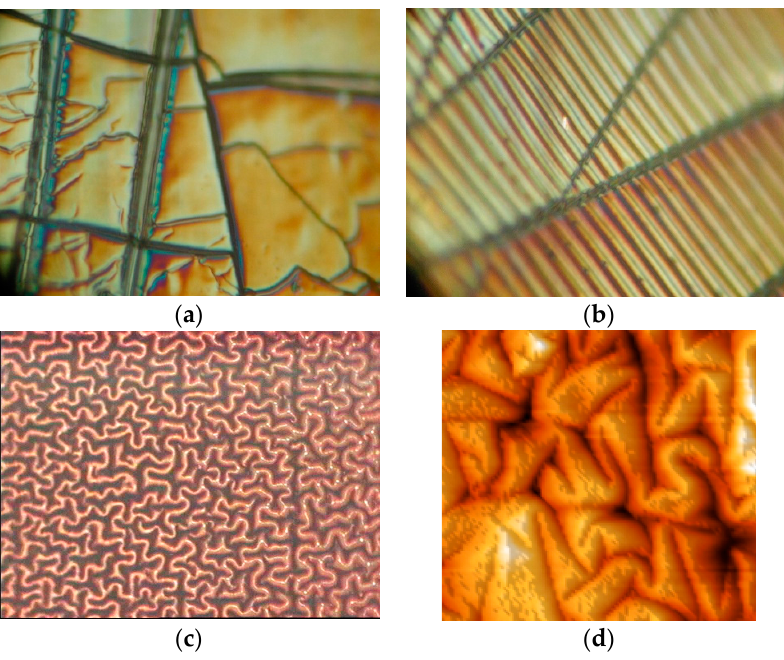
Figure 5. Optical microphotograph ( a – c , 20 × 24 μ m) and AFM image ( d ) of EPDM rubber after PIII: ( a ) 10 14 ions/cm 2 PIII treated EPDM; ( b ) 10 15 ions/cm 2 PIII treated EPDM; ( c ) 10 16 ions/cm 2 PIII treated EPDM; ( d ) AFM image of 10 16 ions/cm 2 PIII treated EPDM (7 × 7 μ m with 244 nm height amplitude).